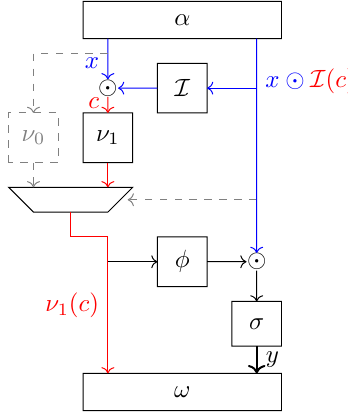
Figure 5: The propagation of particular vector spaces through 𝜋